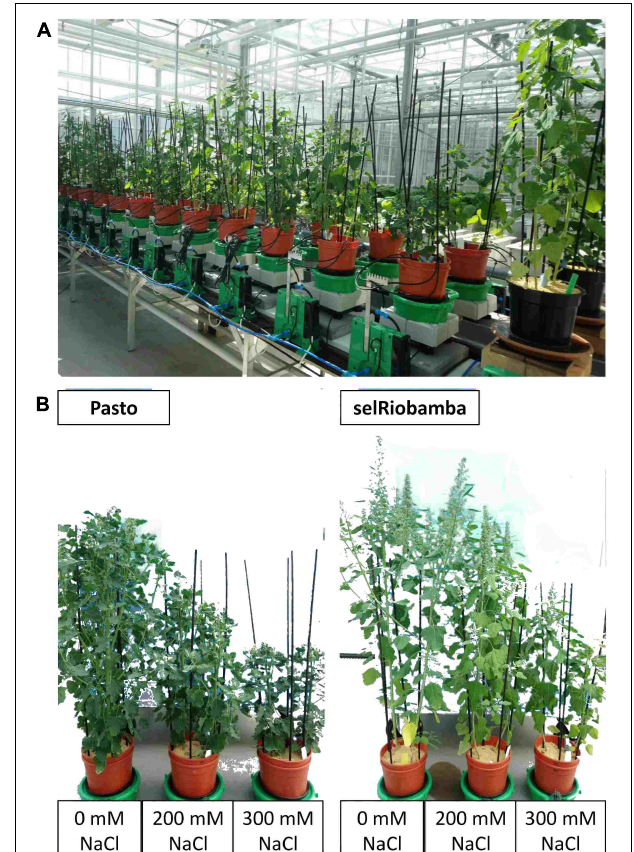
FIGURE 1 | (A) Plant Array 3.0 platform used in this study. Each pot is positioned in a sensitive load cell connected to a control unit. (B) Pasto and selRiobamba at 77 DAS (6 weeks after the start of the salt